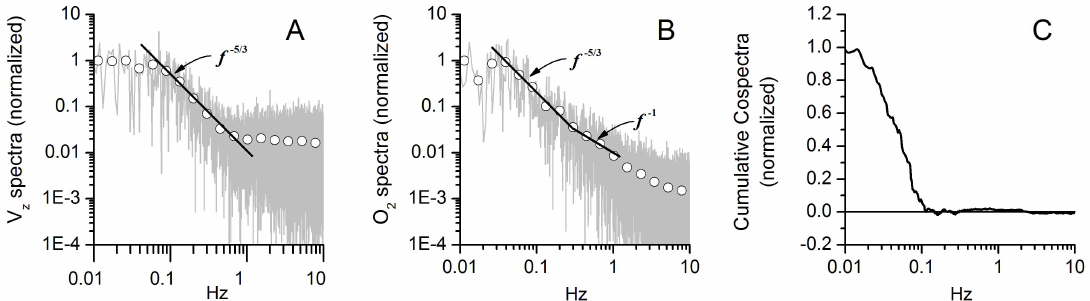
Fig. 3. Typical spectra for current-driven turbulent flow under sea-ice (current velocity: 1.86cms − 1 ) . (A) and (B) show the normalized spectra of the vertical velocity and the O 2 concentration, respectively. The − 5/3 slopes are indicative of well-developed turbulence and represent the inertial subrange where inertial forces dominate transport, according to Kolmogorov’s theory of turbulence. The − 1 slope at higher frequencies in the O 2 spectrum indicates the transport of O 2 by both viscous and convective forces. (C) shows the normalized cumulative cospectrum of vertical velocity and O 2 and revealed that eddies with frequencies < ∼ 0.1Hz contributed most of the vertical turbulence-driven O 2 transport.